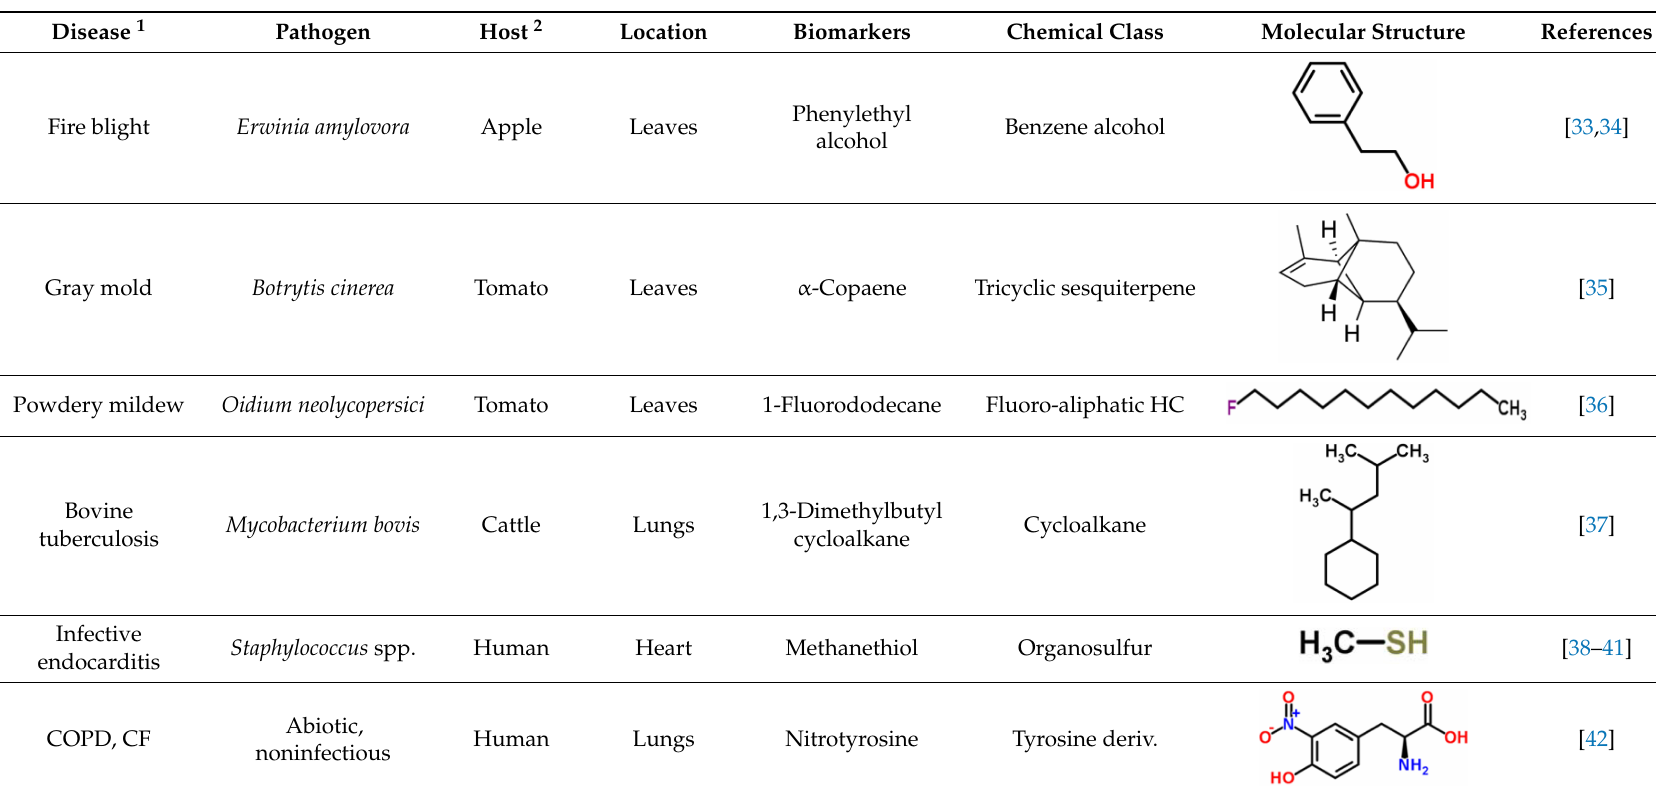
Table 1. Chemical classes and molecular structures of representative volatile organic compounds (VOCs) biomarker metabolites associated with specific plant, animal, and human